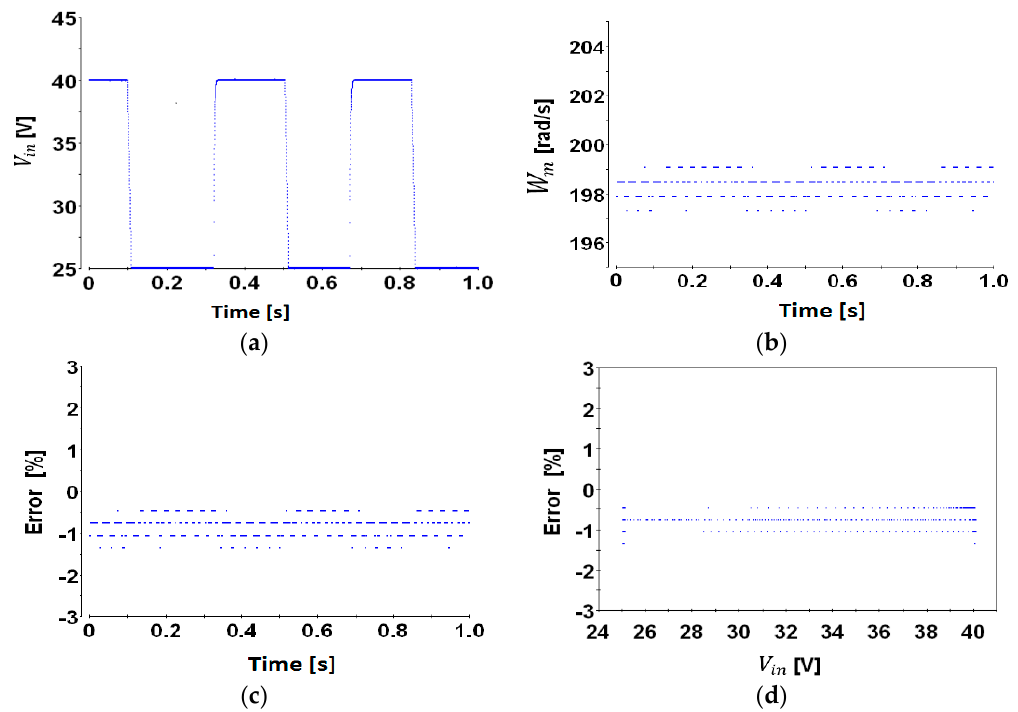
Figure 16. Behavior of the buck-motor system when perturbations in V in are presented for the experimental test with K S 3 = 40, K S 1 = K S 2 = 2, and N = 1: ( a ) variation of V in over time; ( b ) regulated signal W m over time; ( c ) error in the controlled variable; and ( d ) phase diagram of the error vs. V in .